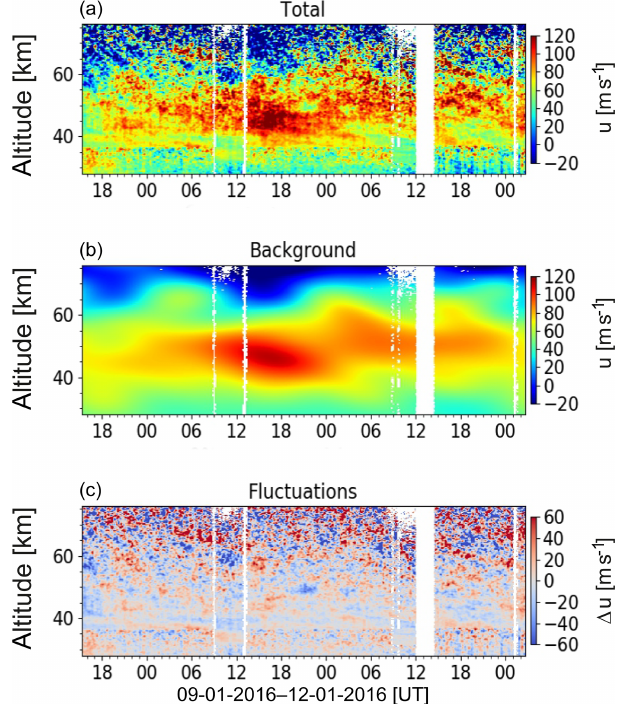
Figure 4. The same as Fig. 3 but for meridional wind